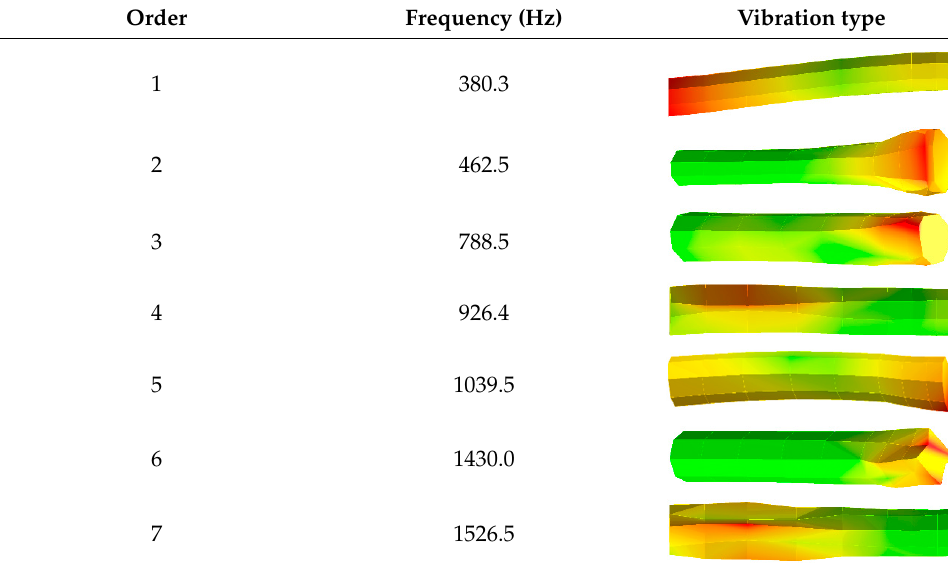
Table 2. The experimental natural frequency values and vibration types.